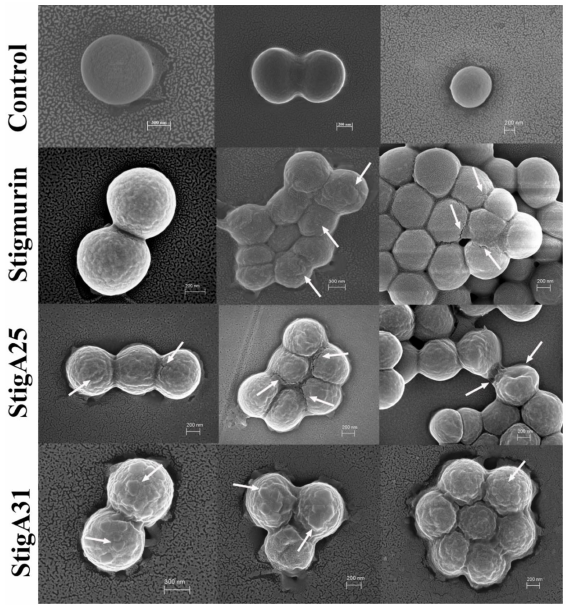
Figure 11. SEM image of S. aureus treated with different concentrations of Stigmurin, StigA25 and StigA31 after 18 h. The arrows indicate the changes promoted in the smooth surface of S. aureus cells by the peptides, making it possible to observe protuberances and cracks in the cell wall. Three images were used for the control and for each peptide to demonstrate all the morphological changes